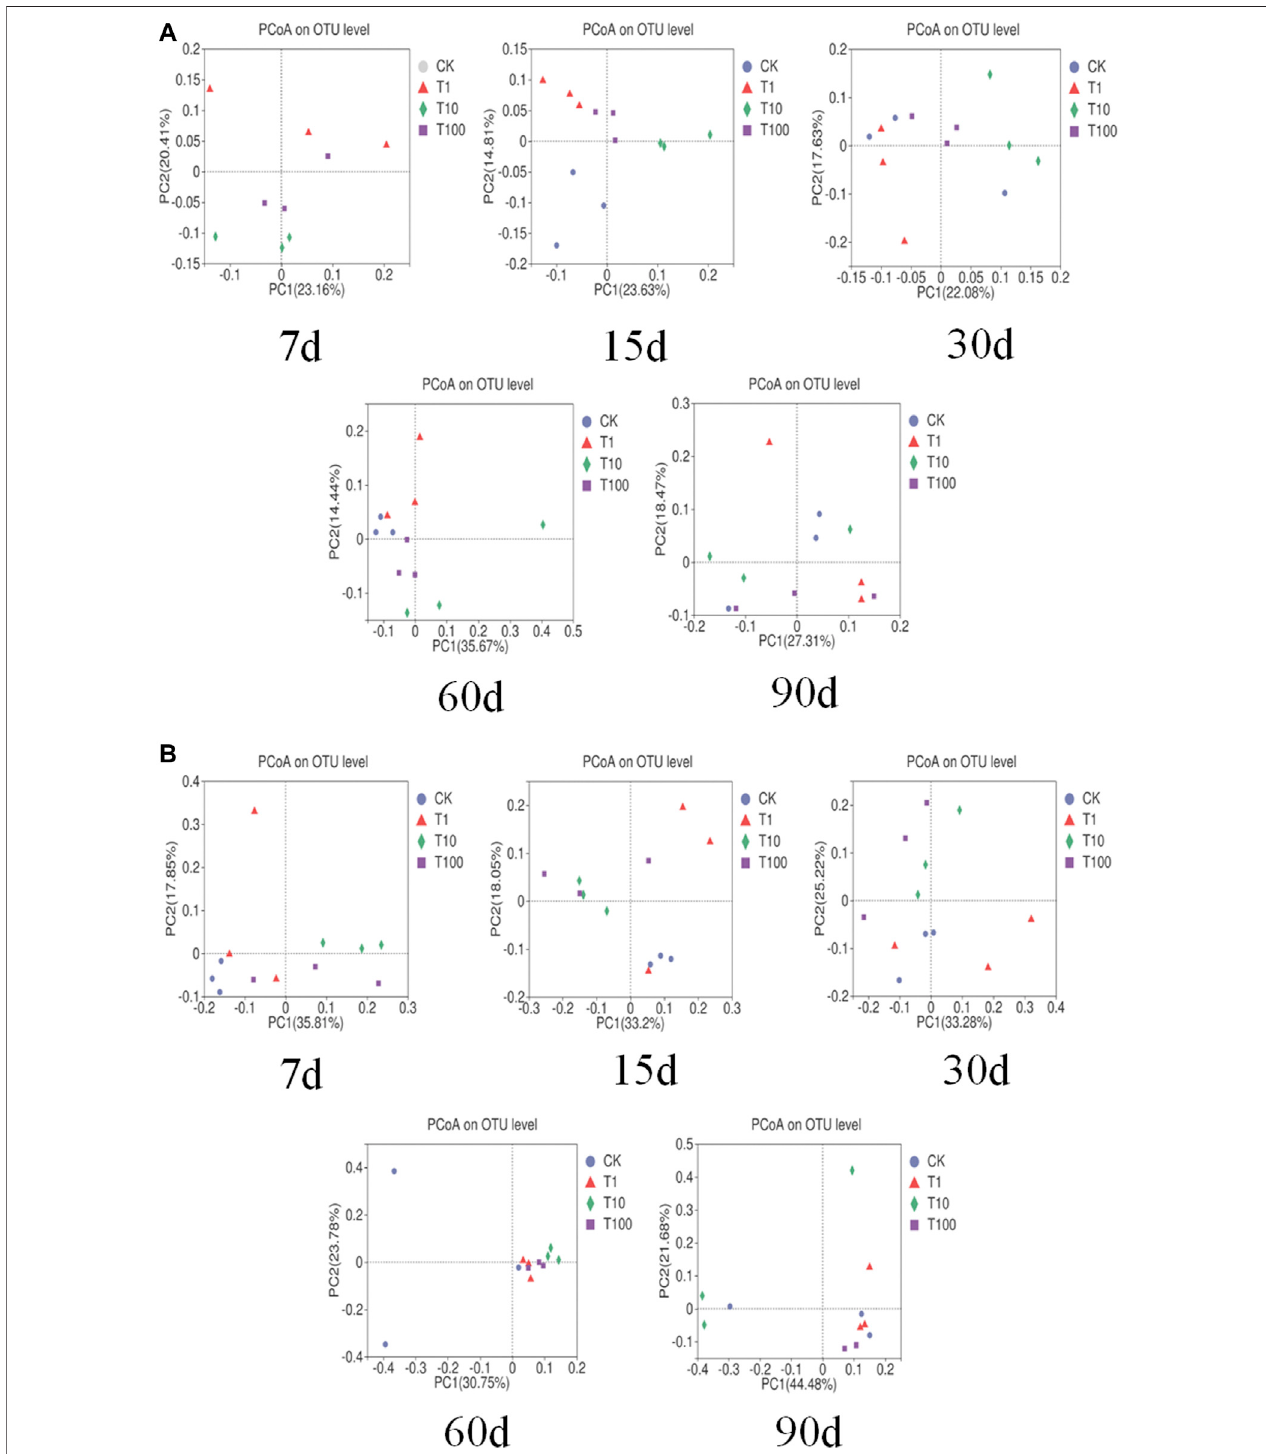
FIGURE 2 | PCoA of bacteria and fungi in soil-based on Bary-Curtis short. (A) is bacteria PCoA, (B) for the fungus PCoA.